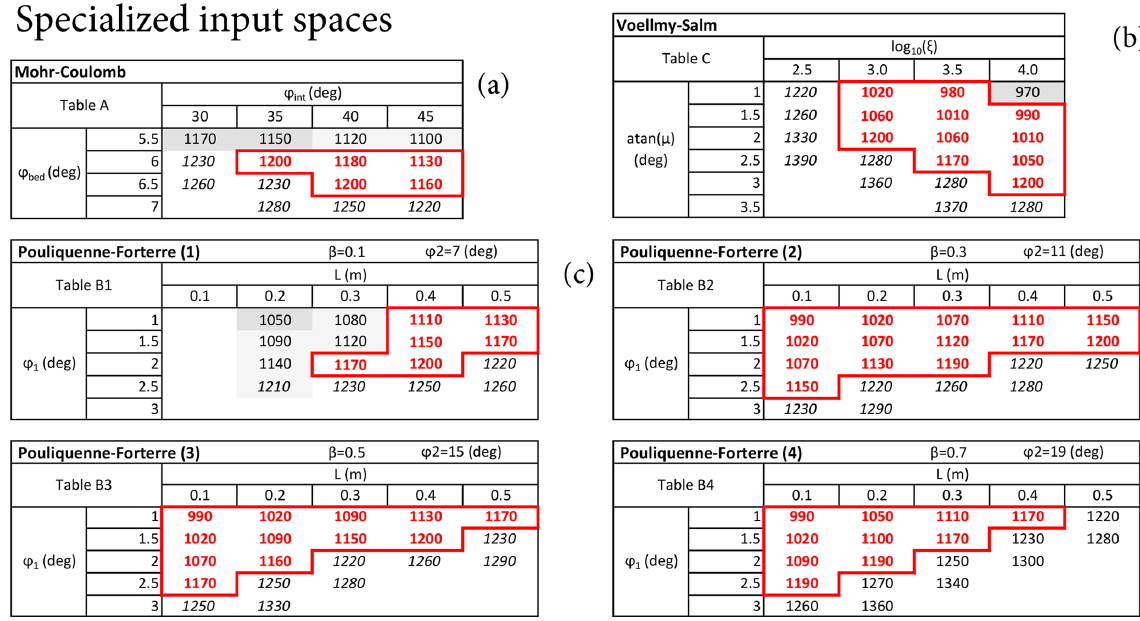
Figure 3. Input space exploration and testing of (a) MC, (b) VS, and (c) PF models, V = 4 . 18 × 10 6 m 3 . The 3-D input space of PF is described by four 2-D subspaces. Values reported are the minimum elevation ζ reached at t = 1200s. A gray background marks those inputs that generate unphysical flow runup and overspill the ravine walls: light gray is > 0 . 1m, and dark gray is > 1m. Red lines mark the subdomain (cid:127) j of flows with ζ ≤ 1200m and without significant overspill